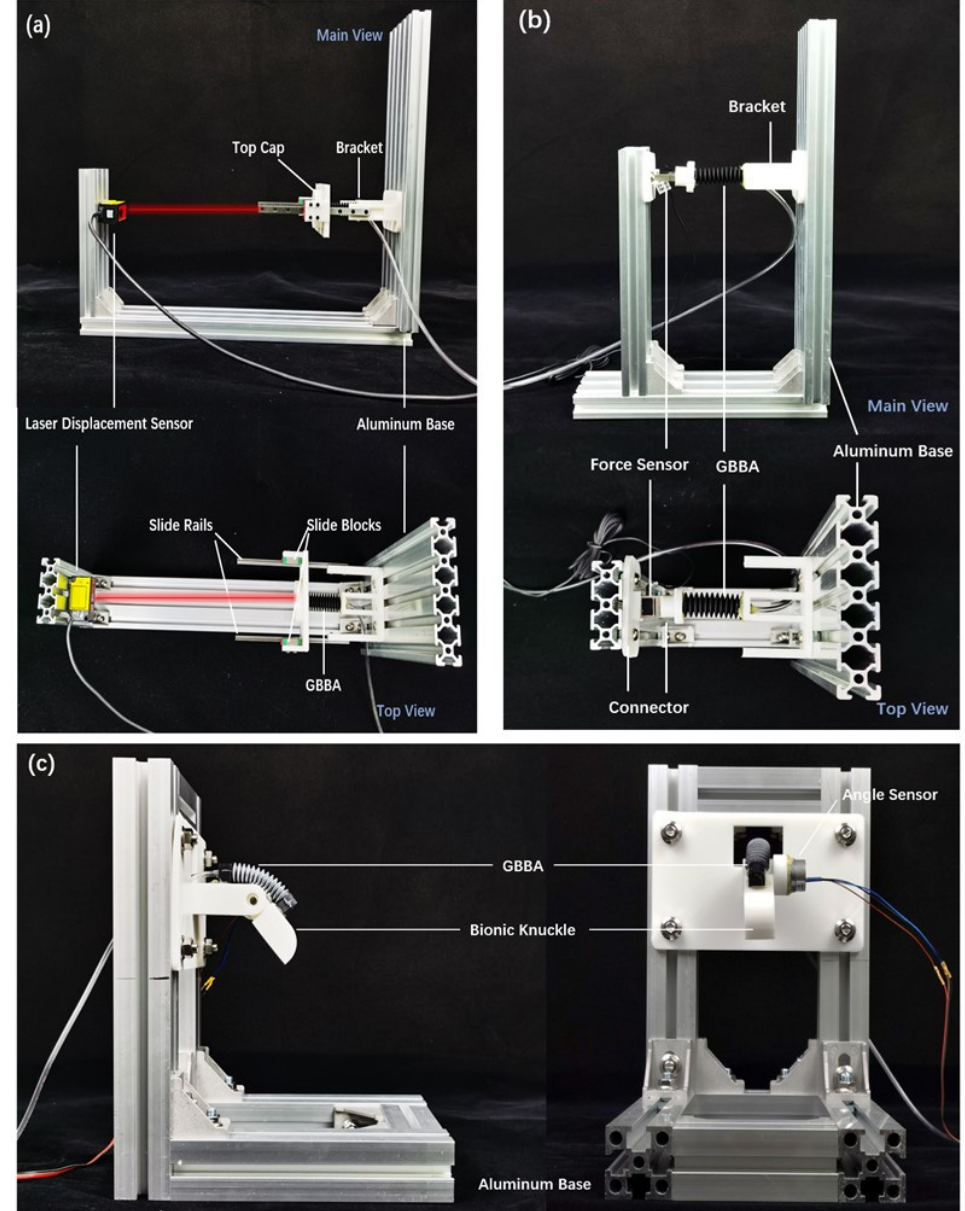
Figure 5. Experiments of a single GBBA: ( a ) output displacement experiment; ( b ) output force experiment; ( c ) bending experiment of single GBBA acting on a non-damping bionic finger joint.